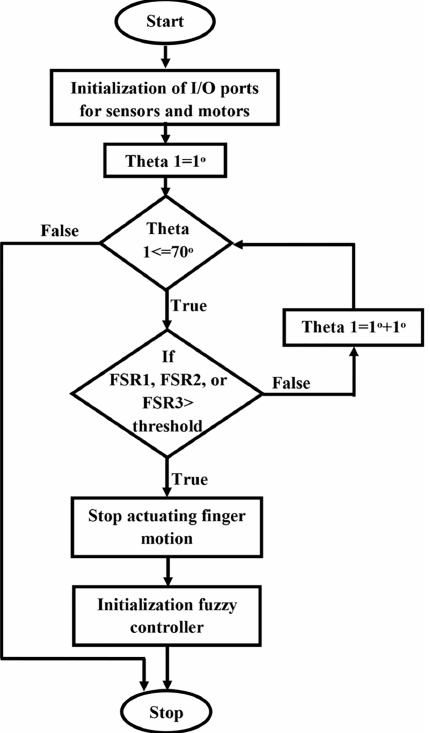
Figure 20. Program flowchart of the control algorithms for each finger. Table 4. Process parameters of testing the control algorithm.